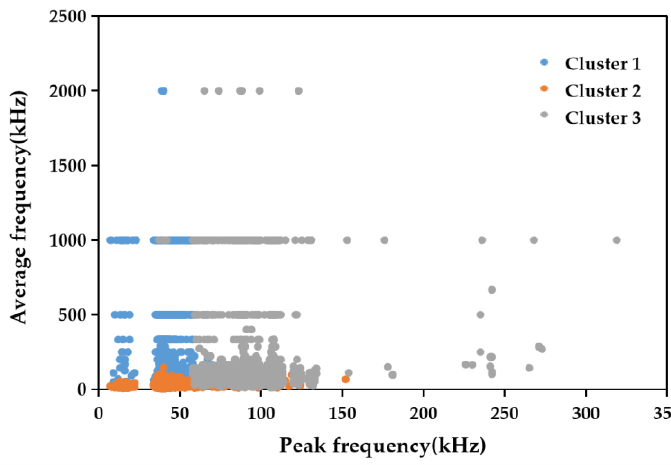
Figure 8. Density peak clustering results.